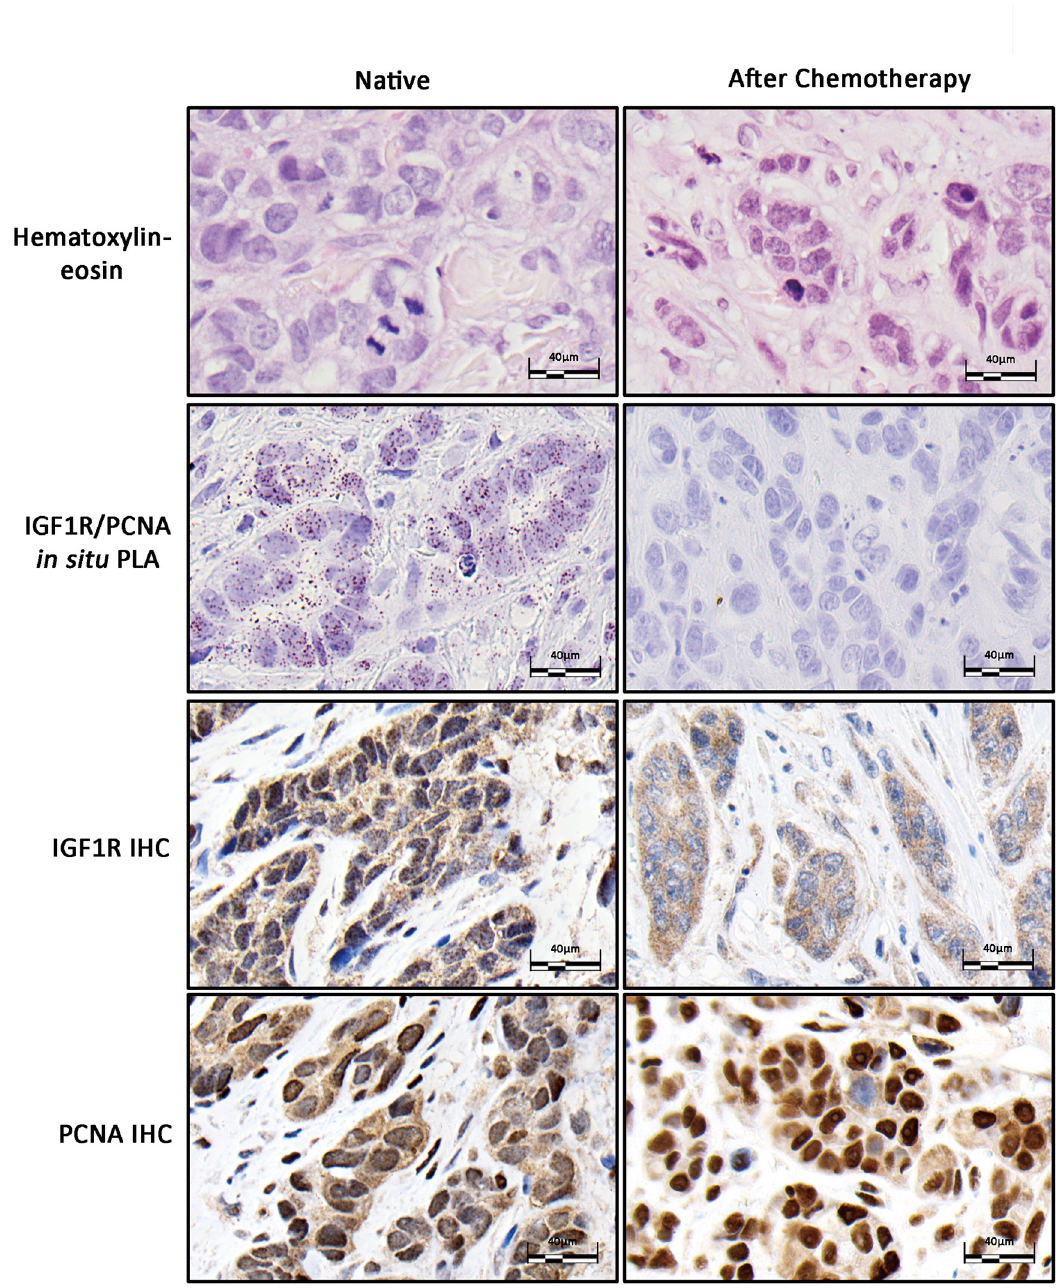
Fig 2. In situ PLA and immunohistochemistry of IGF1R and PCNA in a neoadjuvantly treated breast carcinoma. Representative microphotographs of a neoadjuvantly treated ductal type breast cancer (no special type, Nottingham grade 3). The preoperative biopsy (left) showed nuclear immunoreactivity of IGF1R as well as IGF1R/PCNA colocalization by PLA. In the surgical specimen (after neoadjuvant chemotherapy) the viable tumor cells showed intact mitotic rate with an apparent increase in PCNA immunoreactivity. The treated tumor cells showed a marked decrease of nuclear IGF1R-immunoreactivity and a total loss of IGF1R/ PCNA colocalization signals.